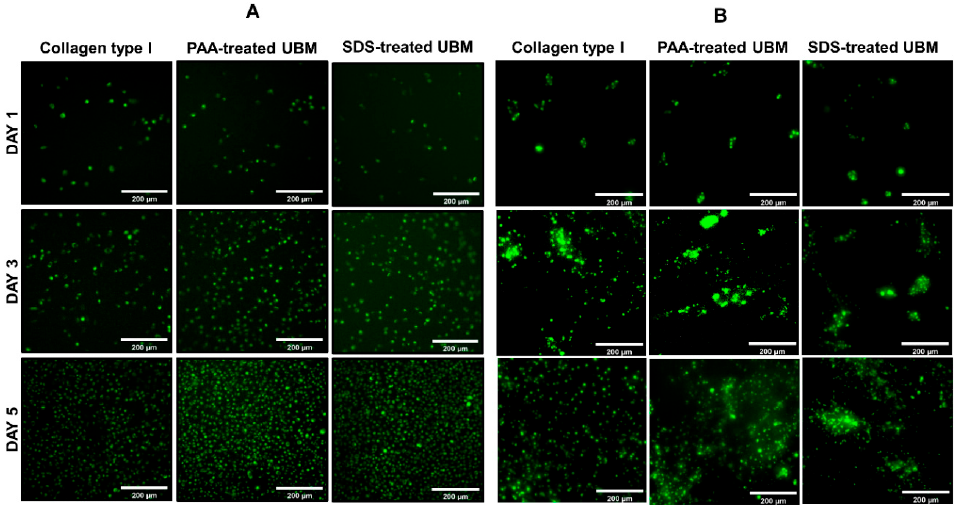
Figure 7. UBM hydrogel cytocompatibility. Live/dead assay of L929 cell cultured on hydrogel surface ( A ) and within hydrogel ( B ) (scale bar: 200 μ m).